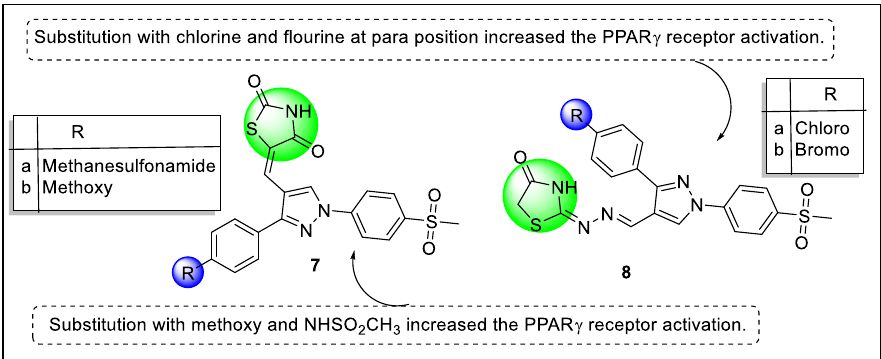
Figure 10. Structural activity relationship of thiazolidinedione ( 7 and 8 ) hybrids as potent PPAR ligands.